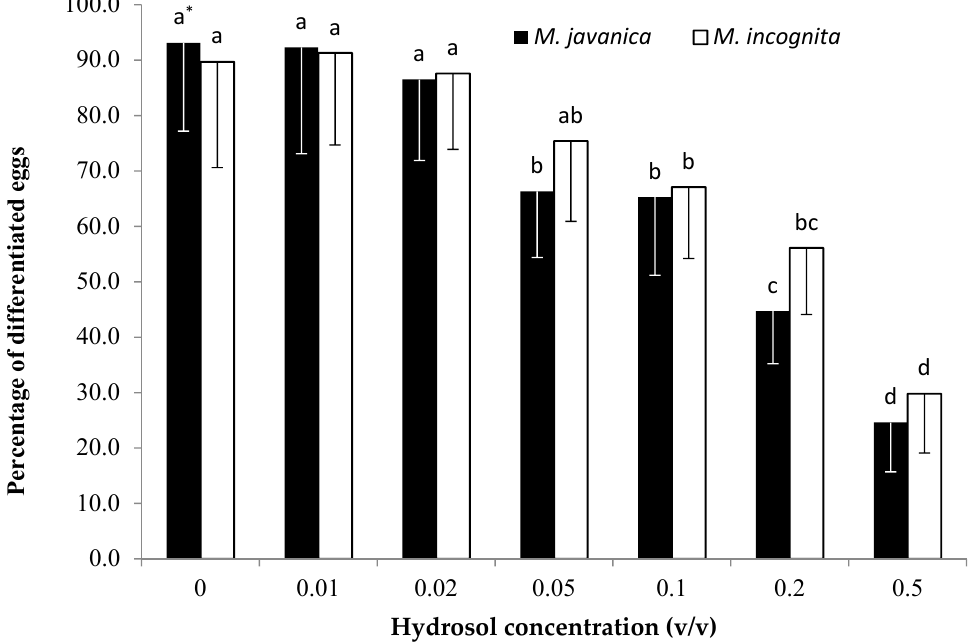
Figure 4. Effect of Cuminum cyminum seed hydrosol on the differentiation of M. incognita and M. javanica eggs after immersion in test solutions at concentrations of 0, 0.01, 0.02, 0.05, 0.1, 0.2, and 0.5 v/v for 28 days. * Bars with the same color followed by the same letter are not significantly different according to Tukey’s HSD test at p < 0.05.